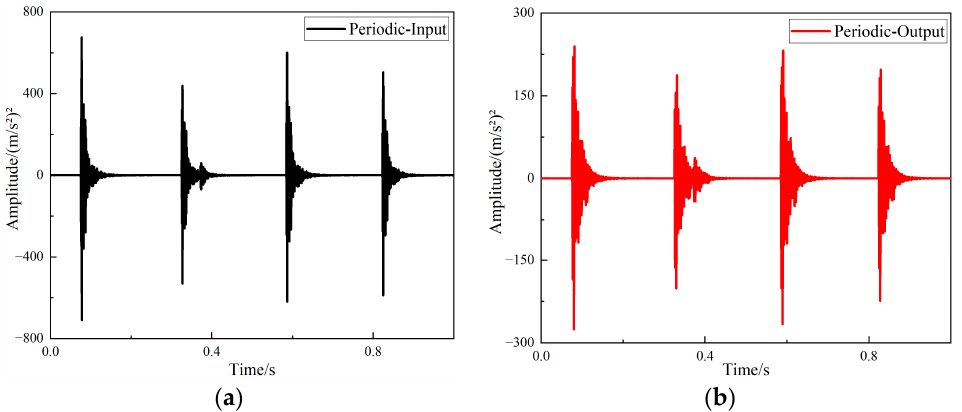
Figure 15. The response curves of the periodic structure support ( a ) Time domain input signal of periodic structure support, ( b ) time domain output signal of periodic structure